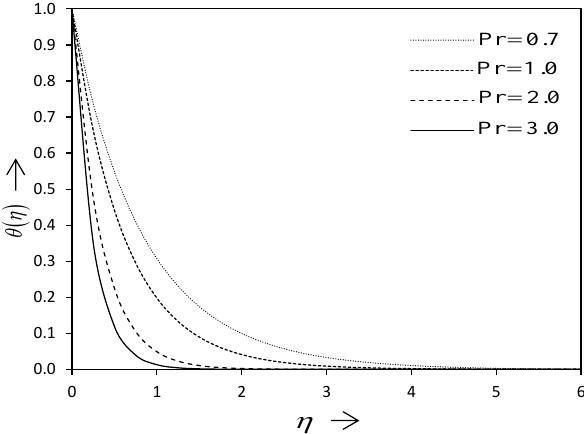
Figure 8. Temperature profiles against  for various values of P r with 1 . 0 , 0 . 1   A S and 1 . 0 